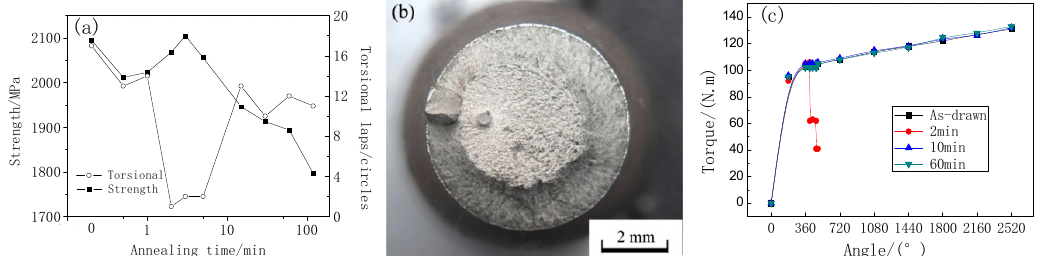
Figure 1. ( a ) Tensile strength and torsional laps and strength curves of steel wires after being held for different times at 450 °C; ( b ) tensile fracture of wires annealed for 3 min; and ( c ) curves of torque vs. torsion angle.